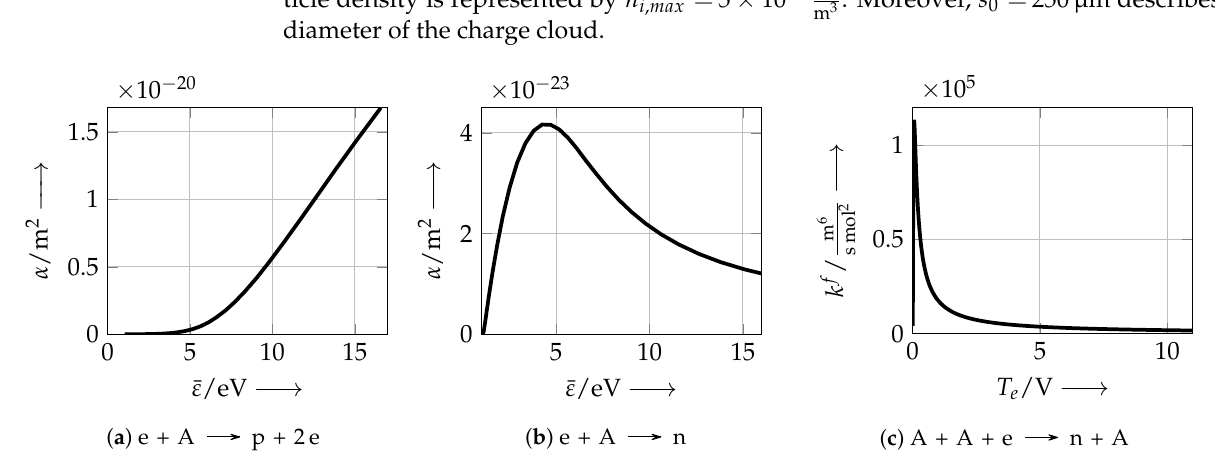
Figure 4. Townsend coefficients and rate constant for different ionization reactions according to